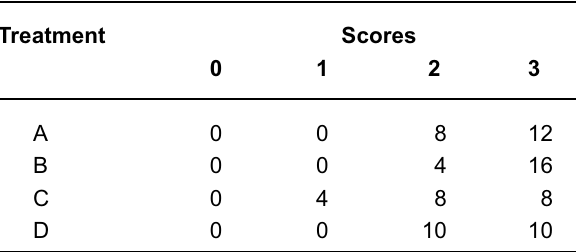
TABLE 3- Distribution of microleakage scores according to